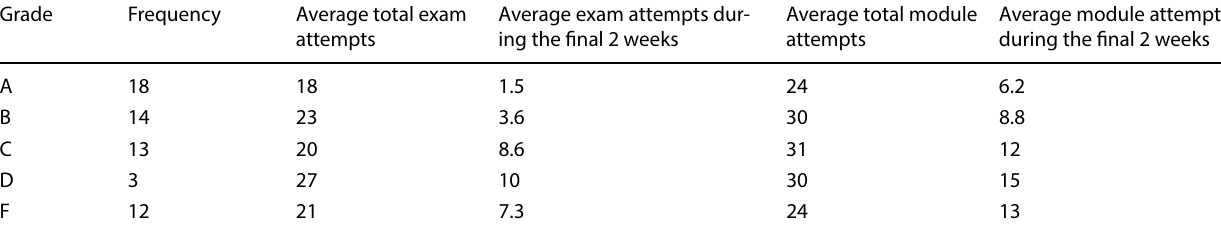
Table 3 Attempts by final grade